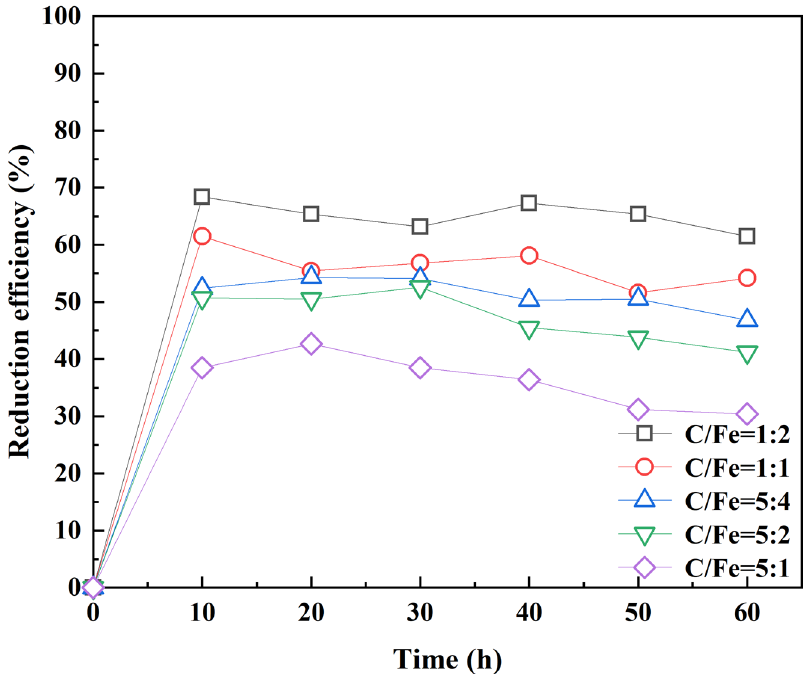
Figure 5. Effect of C/Fe on reducing soil Cr(VI) by RC-nZVI.